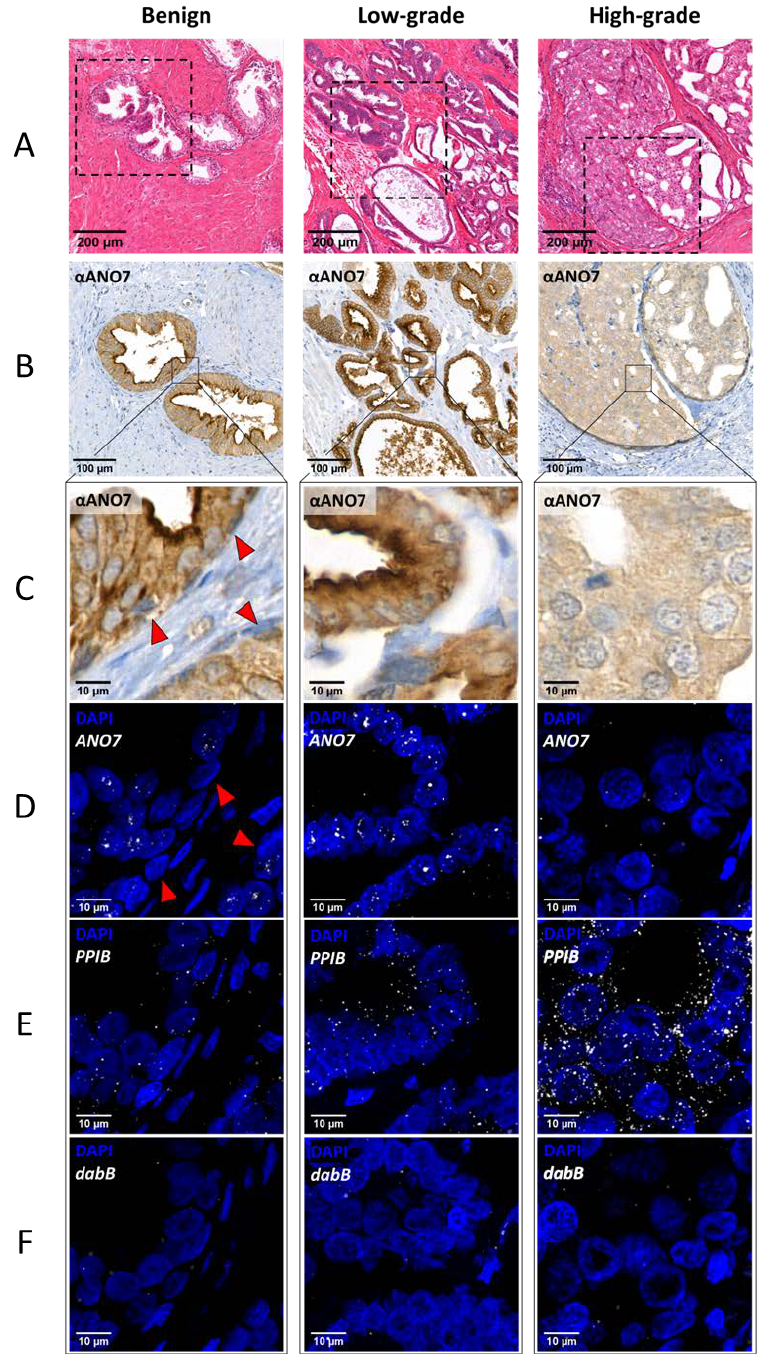
Figure 2. ANO7 mRNA is expressed in luminal cells and accumulates in the nucleus. ANO7 protein and mRNA localization in benign glands (left column), low-grade cancer (middle